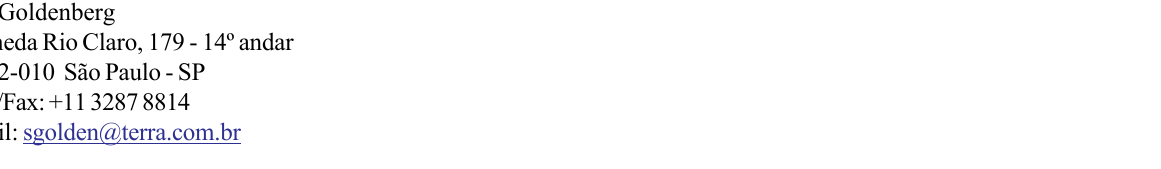
* Figuras coloridas disponíveis em